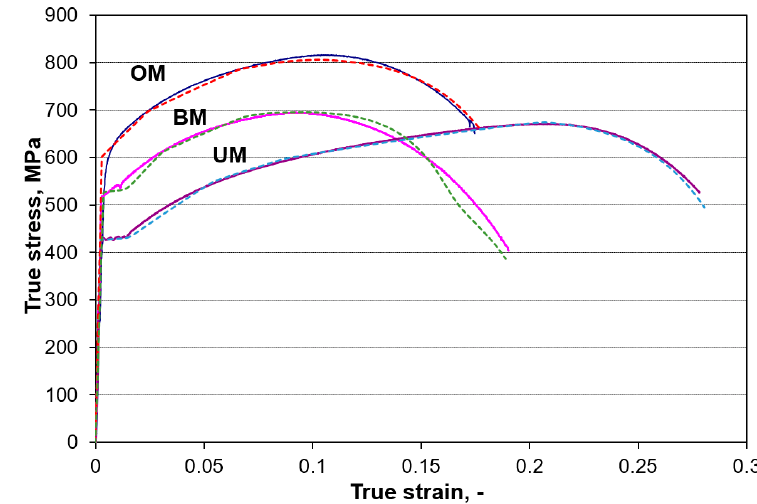
Figure 7. Average mechanical tensile properties obtained by standard tensile testing of round tensile specimens, as is shown in Figure 2a.